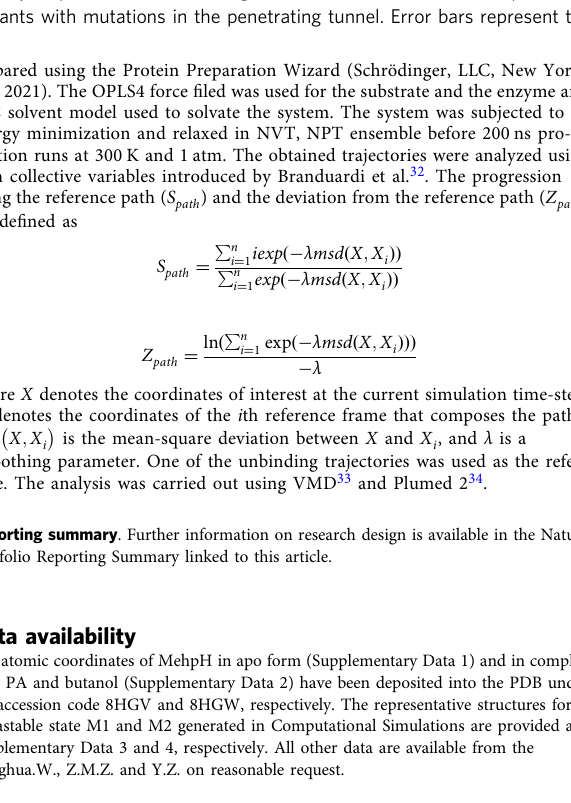
Fig. 4 Egress tunnel analysis for butanol. a The predicted tunnel of MehpH using CAVER 3.0. b The RMSD values of butanol from 24 independent MD simulation runs. c A representative unbinding process of butanol: time evolution of butanol is colored from red (t = 0) to blue (unbound). d Population density map for butanol unbinding from the active center. e The representative structures for metastable state M1 and M2. f Hydrolytic activities of MehpH variants with mutations in the penetrating tunnel. Error bars represent the s.d. values obtained in triplicate